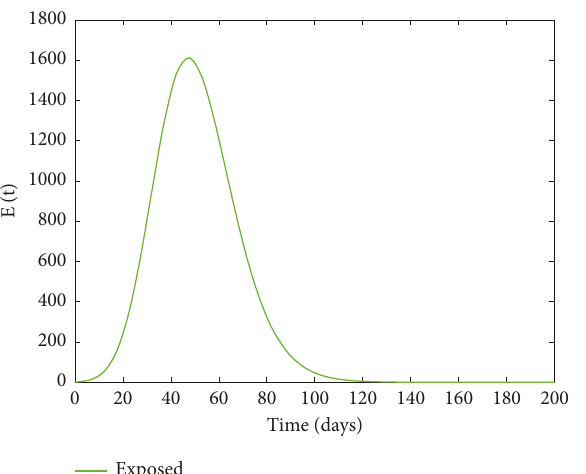
Figure 8: Behaviour of the COVID-19 patients with diabetes.